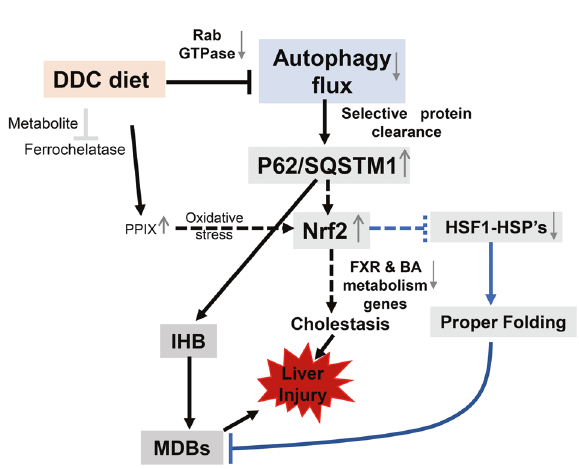
Fig. 9 Schematic model showing role of autophagy in DDC diet. Acute DDC impairs the autophagic fl ux due to Rab suppression. Impaired autophagy leads to formation of p62 containing intrahyaline bodies (IHB). Impaired autophagy can also relate to downregulation of hepatic protein chaperonin system, further aiding in IHB formation. Further activation of P62 related